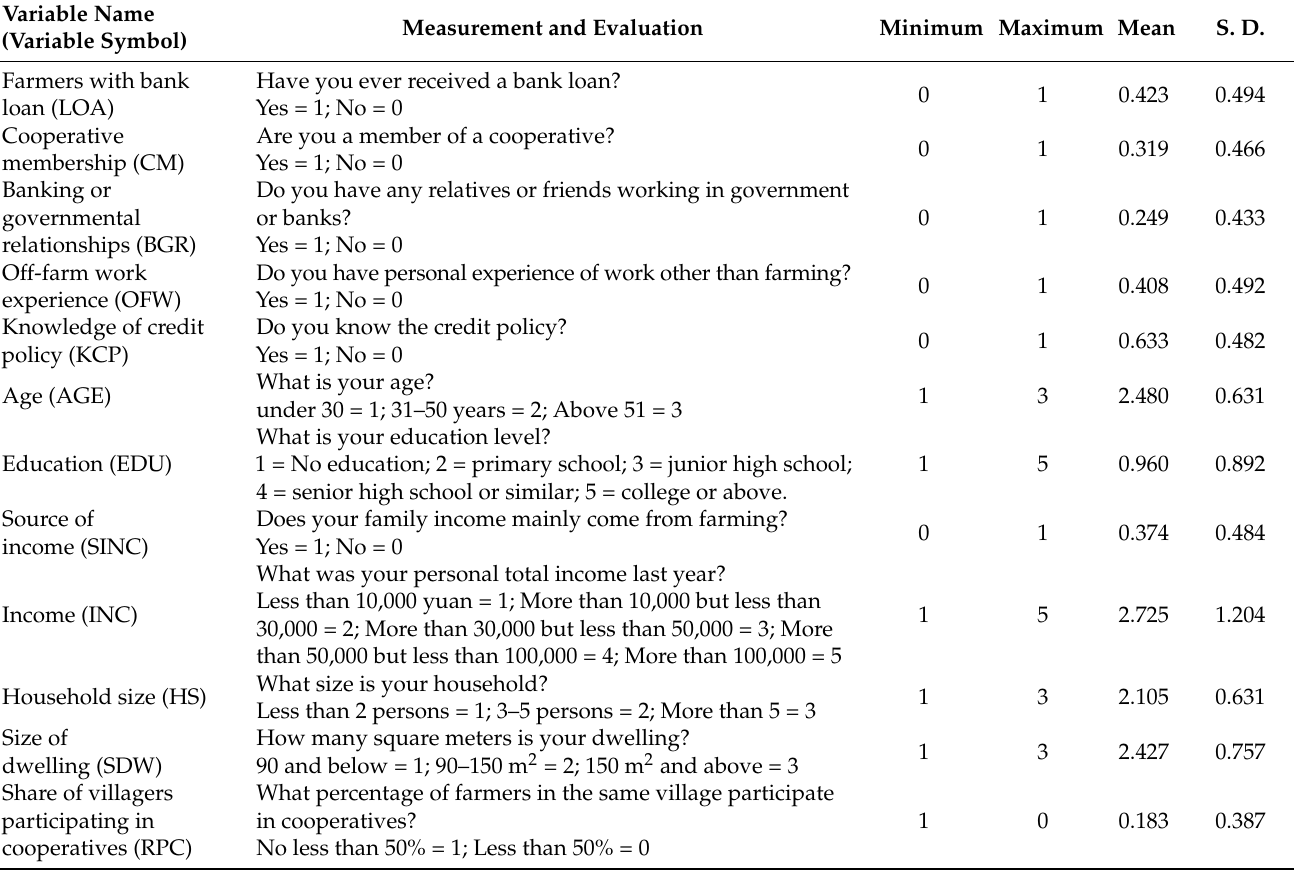
Table 1. Description of farmers’ characteristics.